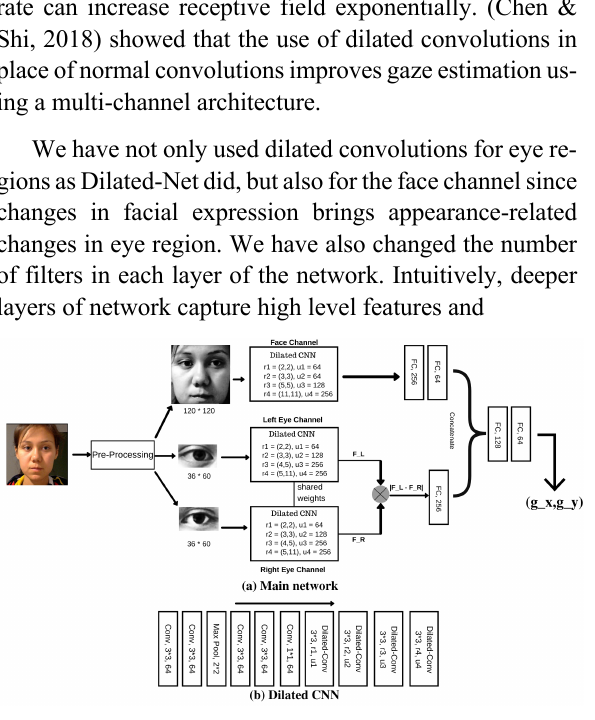
Figure 1: Architecture of I2DNet network. (a) Main network represents our architecture. (b) Dilated CNN represents the generic CNN block that we used across face and both eyes